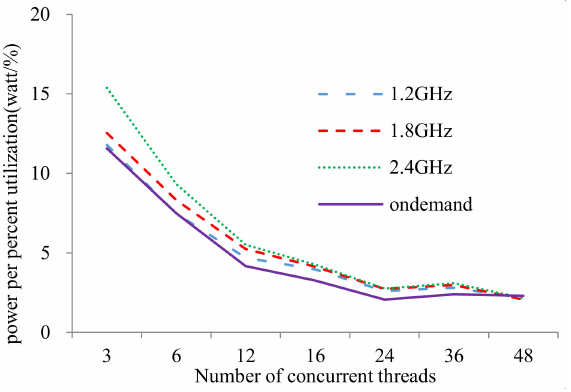
Figure 11. Power per percent memory utilization of server #2 with array size = 4